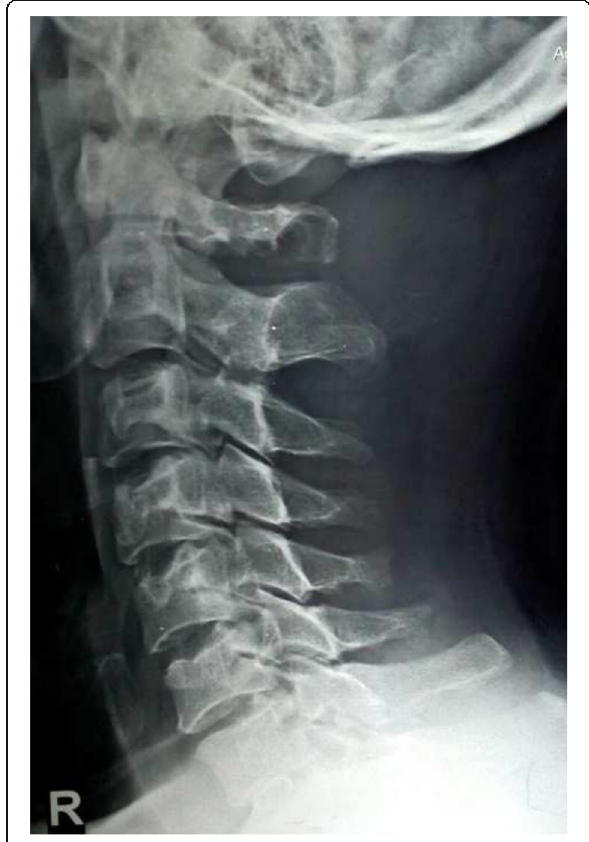
Fig. 1 X-ray showing suspicious lesion just blow the occipital area, posterior to spinous process of cervical spine C1 and